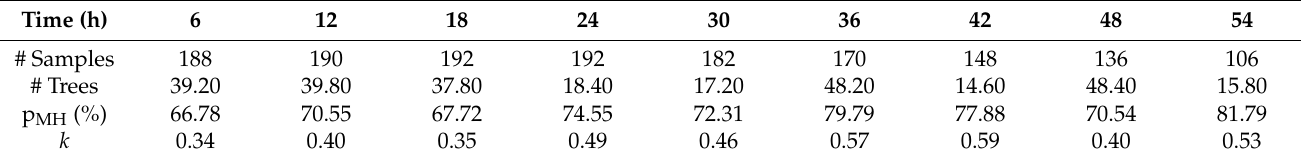
Table 2. As in Table 1, but for the NE Pacific Ocean.